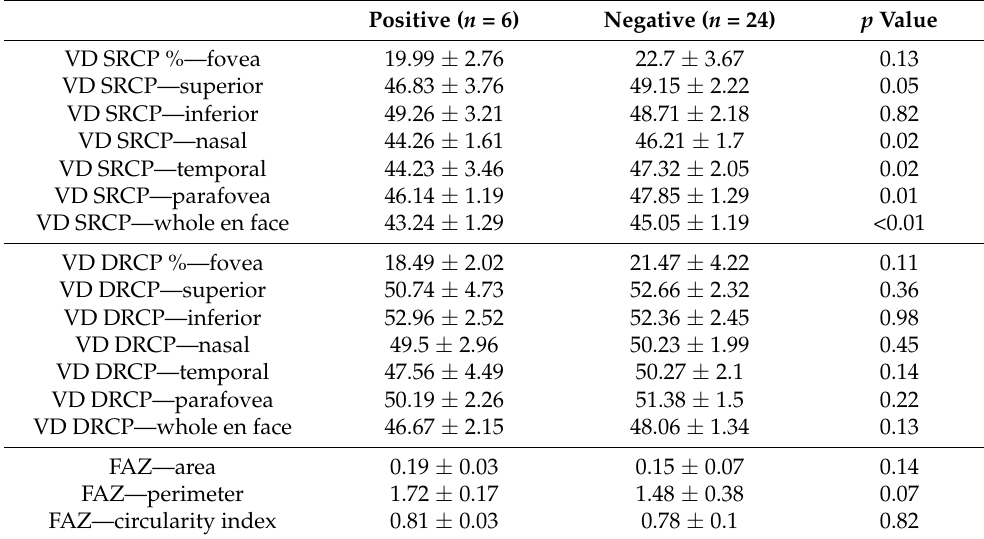
Table 8. Comparison of OCTA parameters among SLE patient with kidney